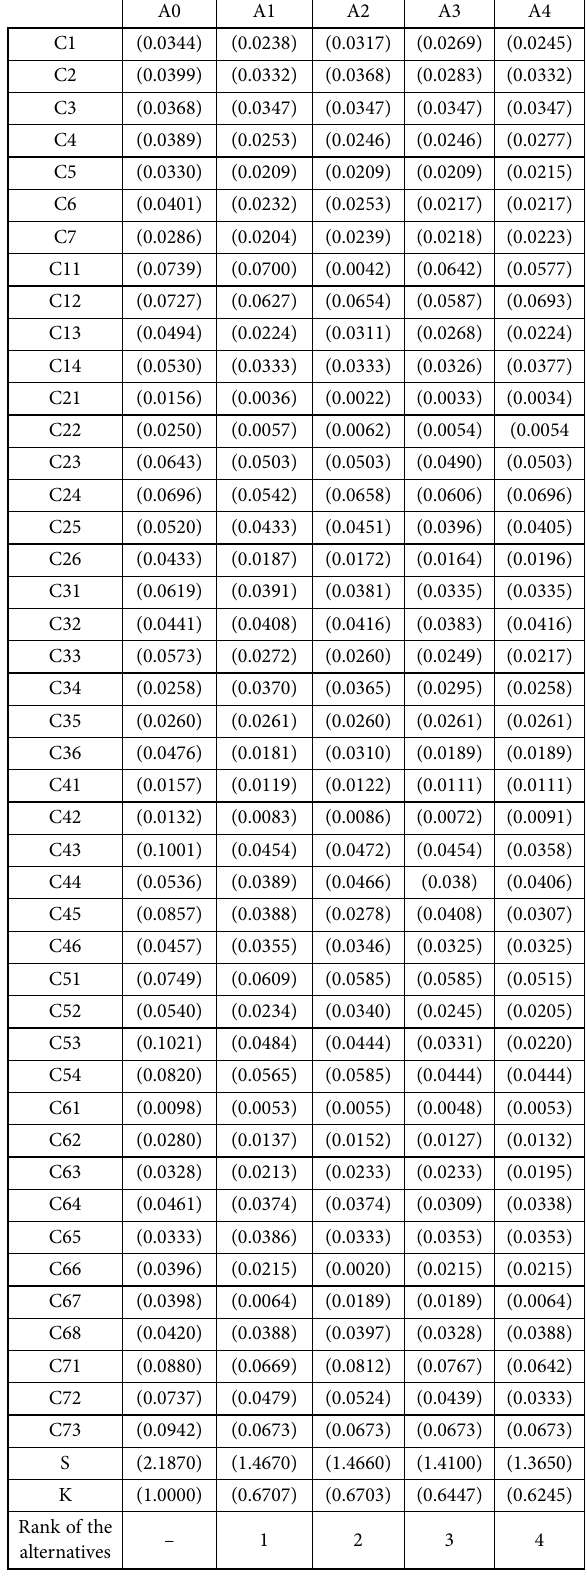
Table 9. Normalized values of defuzzified values from Table 8 Table 10. Weighted-normalized values and solution